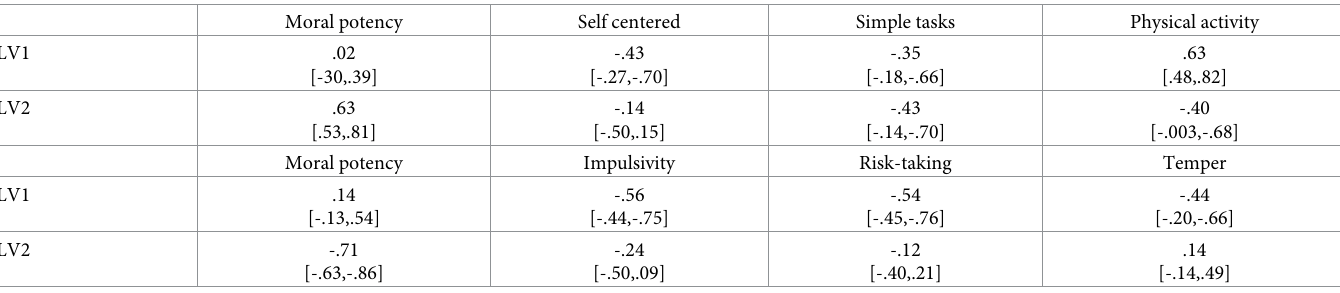
Table 5. Brain-behavior correlations and 95% confidence intervals for moral potency, the two components of self-control, and ERP activity. Moral